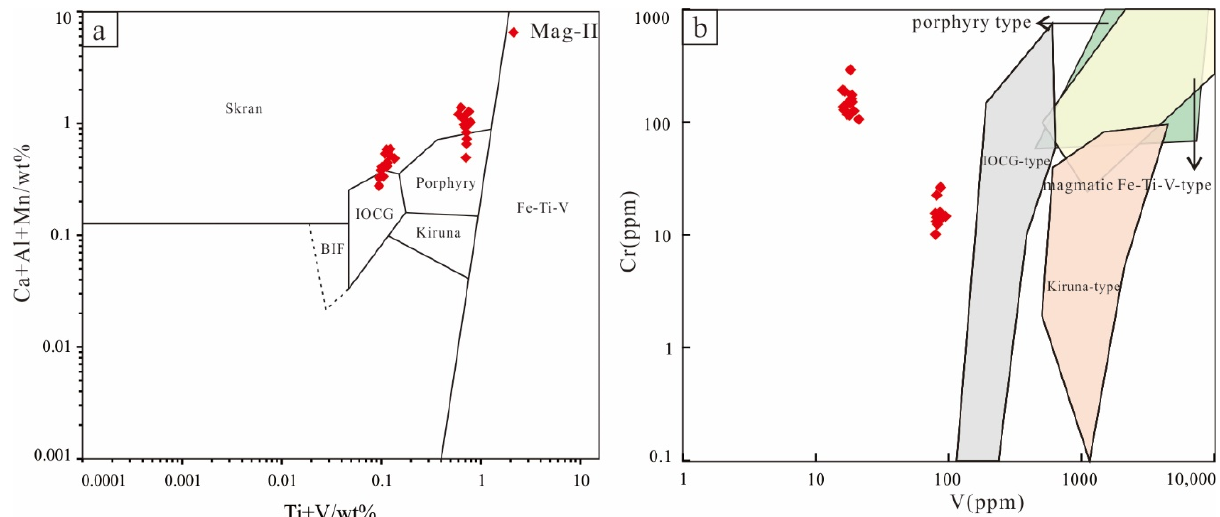
Figure 12. ( a ) Ti + V vs. Ca + Al + Mn (wt. %) discriminant diagrams (modified from Dupuis and Beaudoin. [67]); ( b ) Cr vs. V diagram for magnetite to distinguish different deposit types (modified after Knipping et al. [112] with typical IOCG magnetite compositions from Carew [65] and Dare et al. [63]).